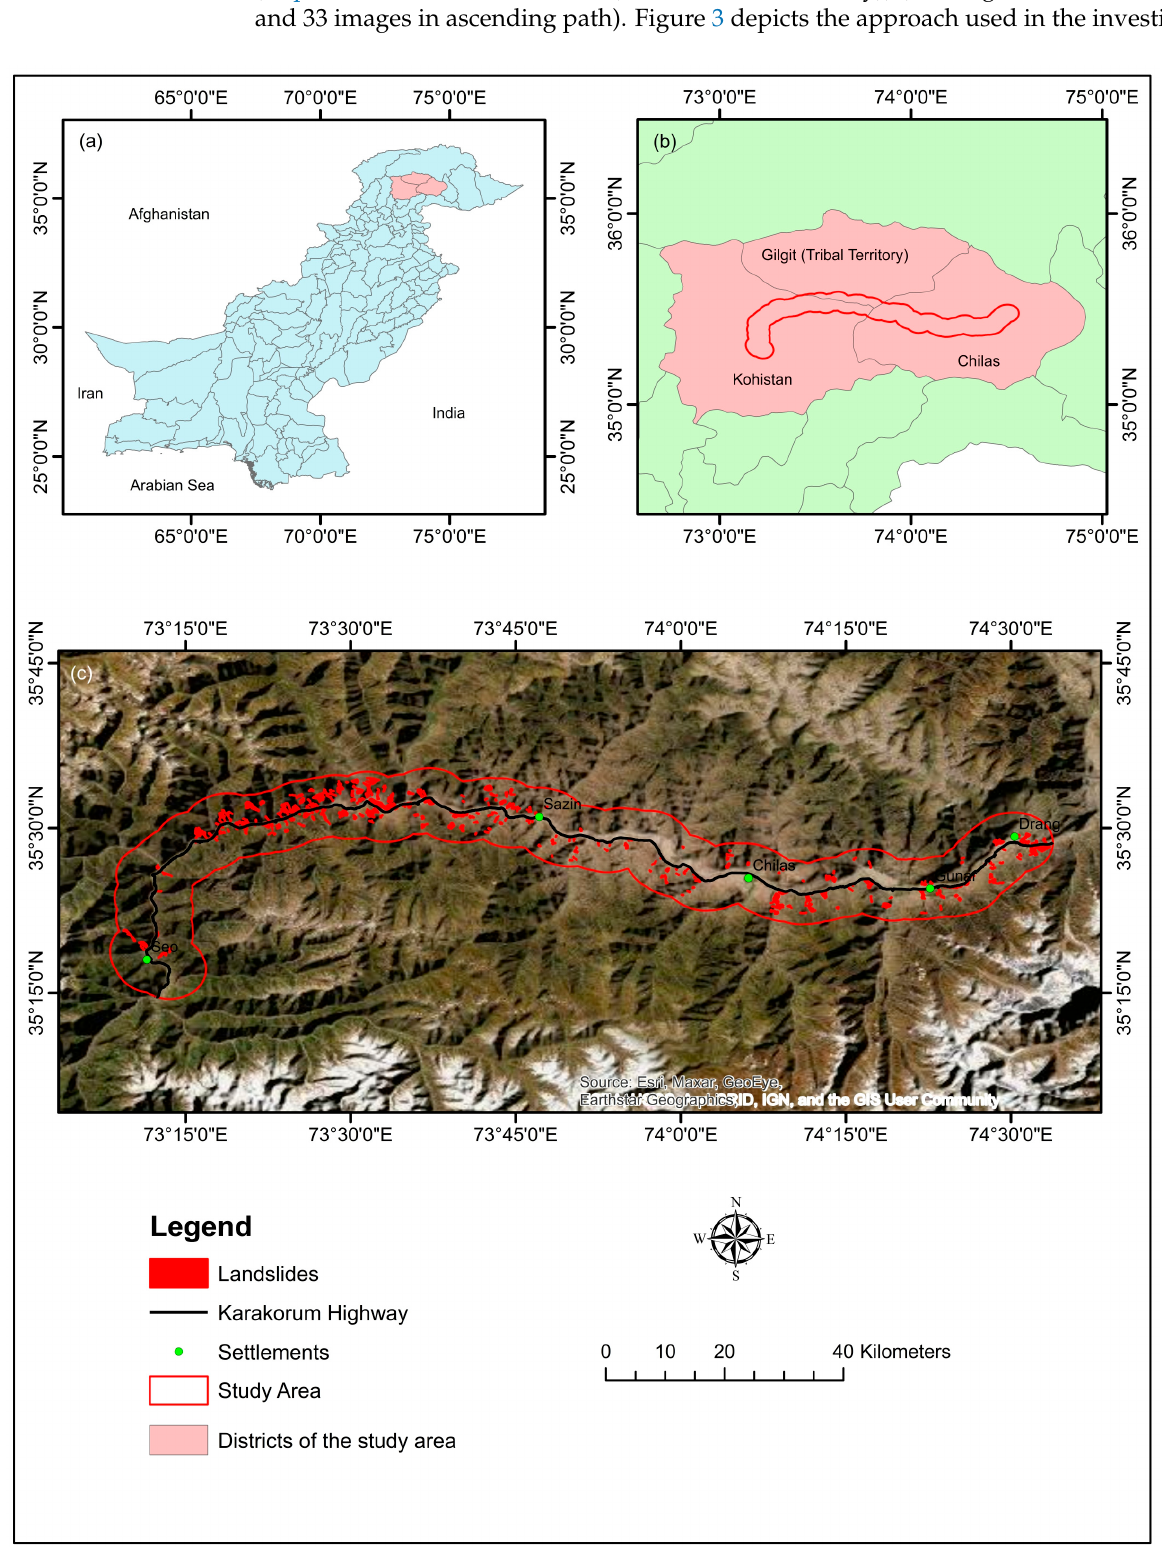
Figure 1. The 541 band combination Landsat image showing the area under investigation. ( a ) Pakistan, ( b ) District boundaries, ( c ) Study area in red outline.